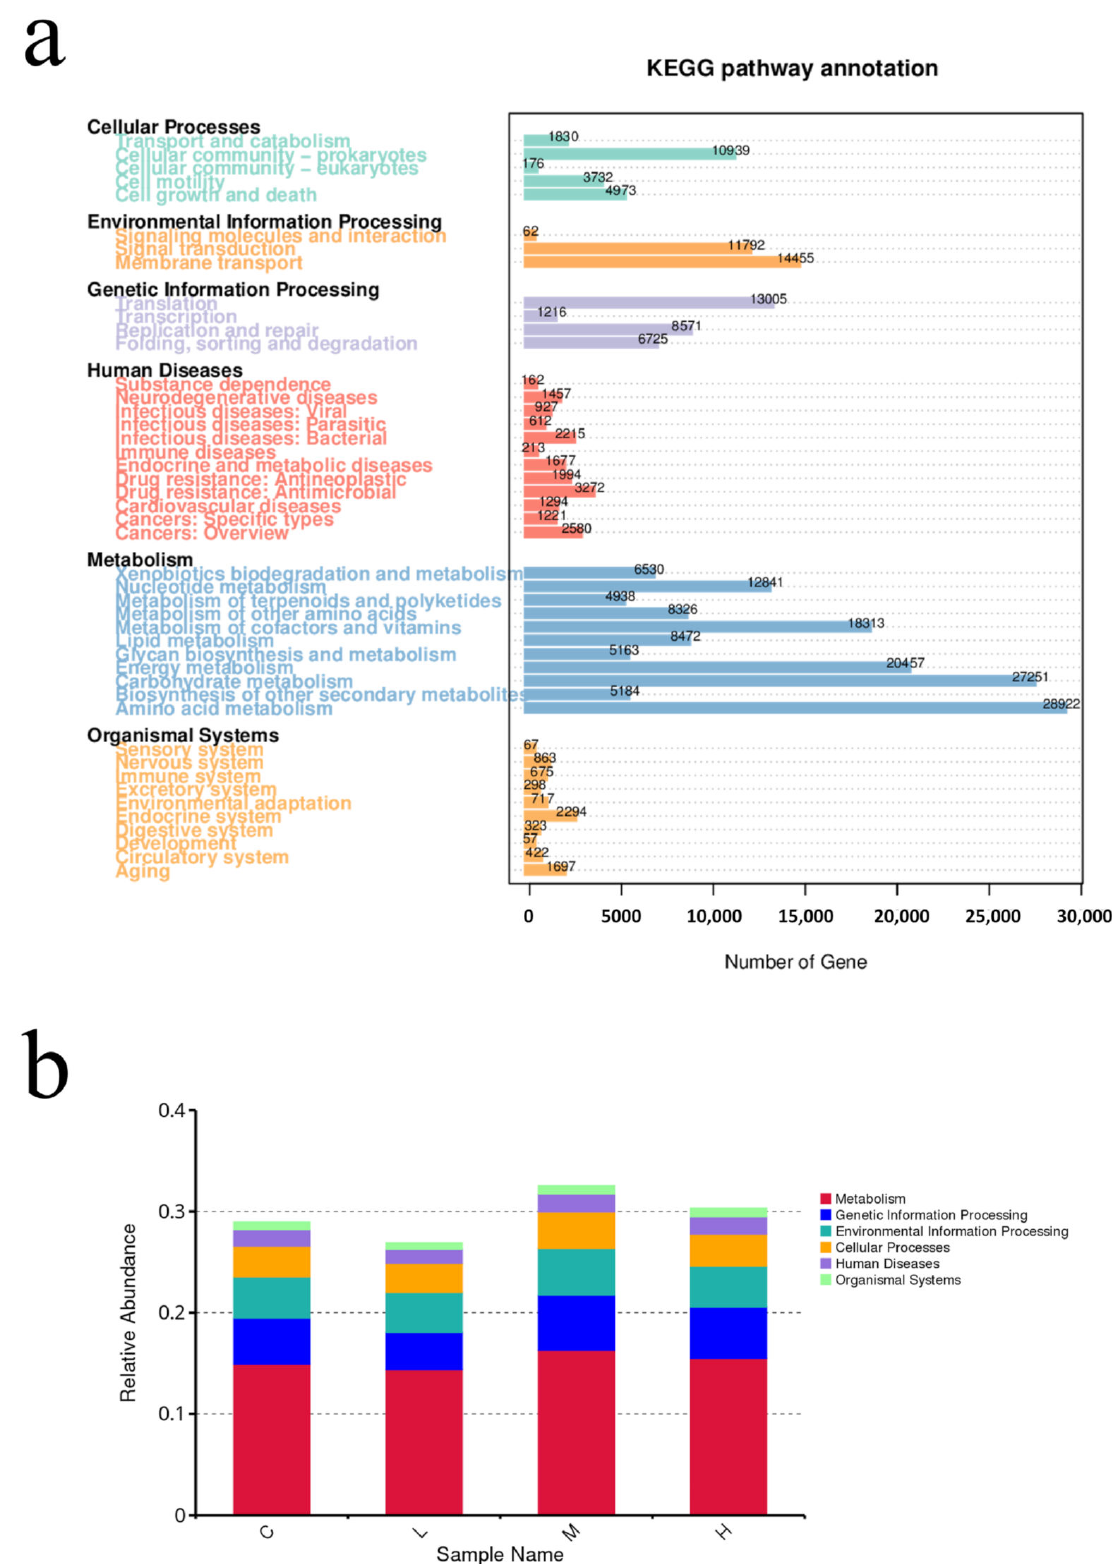
Figure 9. ( a ) Functional prediction of the KEGG metabolic pathway. ( b ) Histogram of relative abundance of functional annotations on